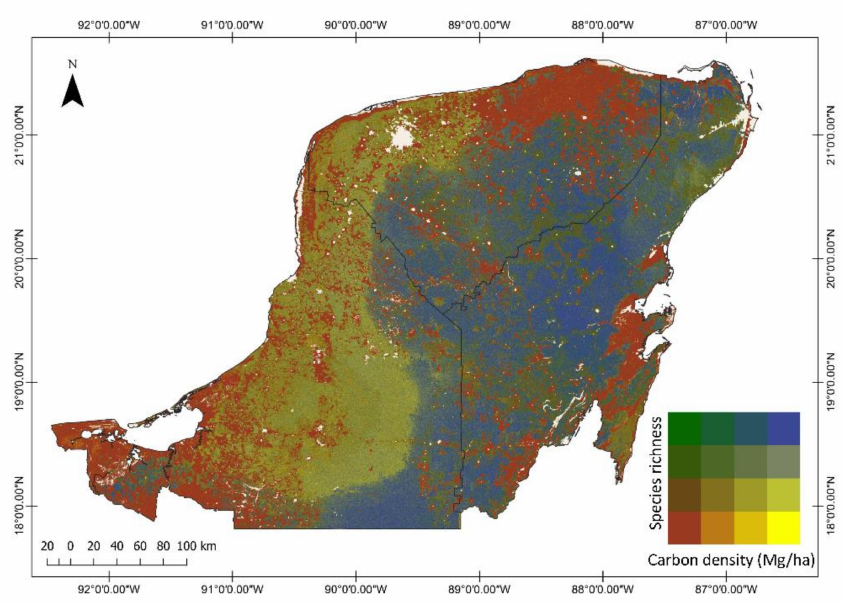
Figure 5. Map of the Yucatan Peninsula showing congruence between carbon density and species richness of trees. The hotspot areas that have high values for both carbon density and species richness are shown in